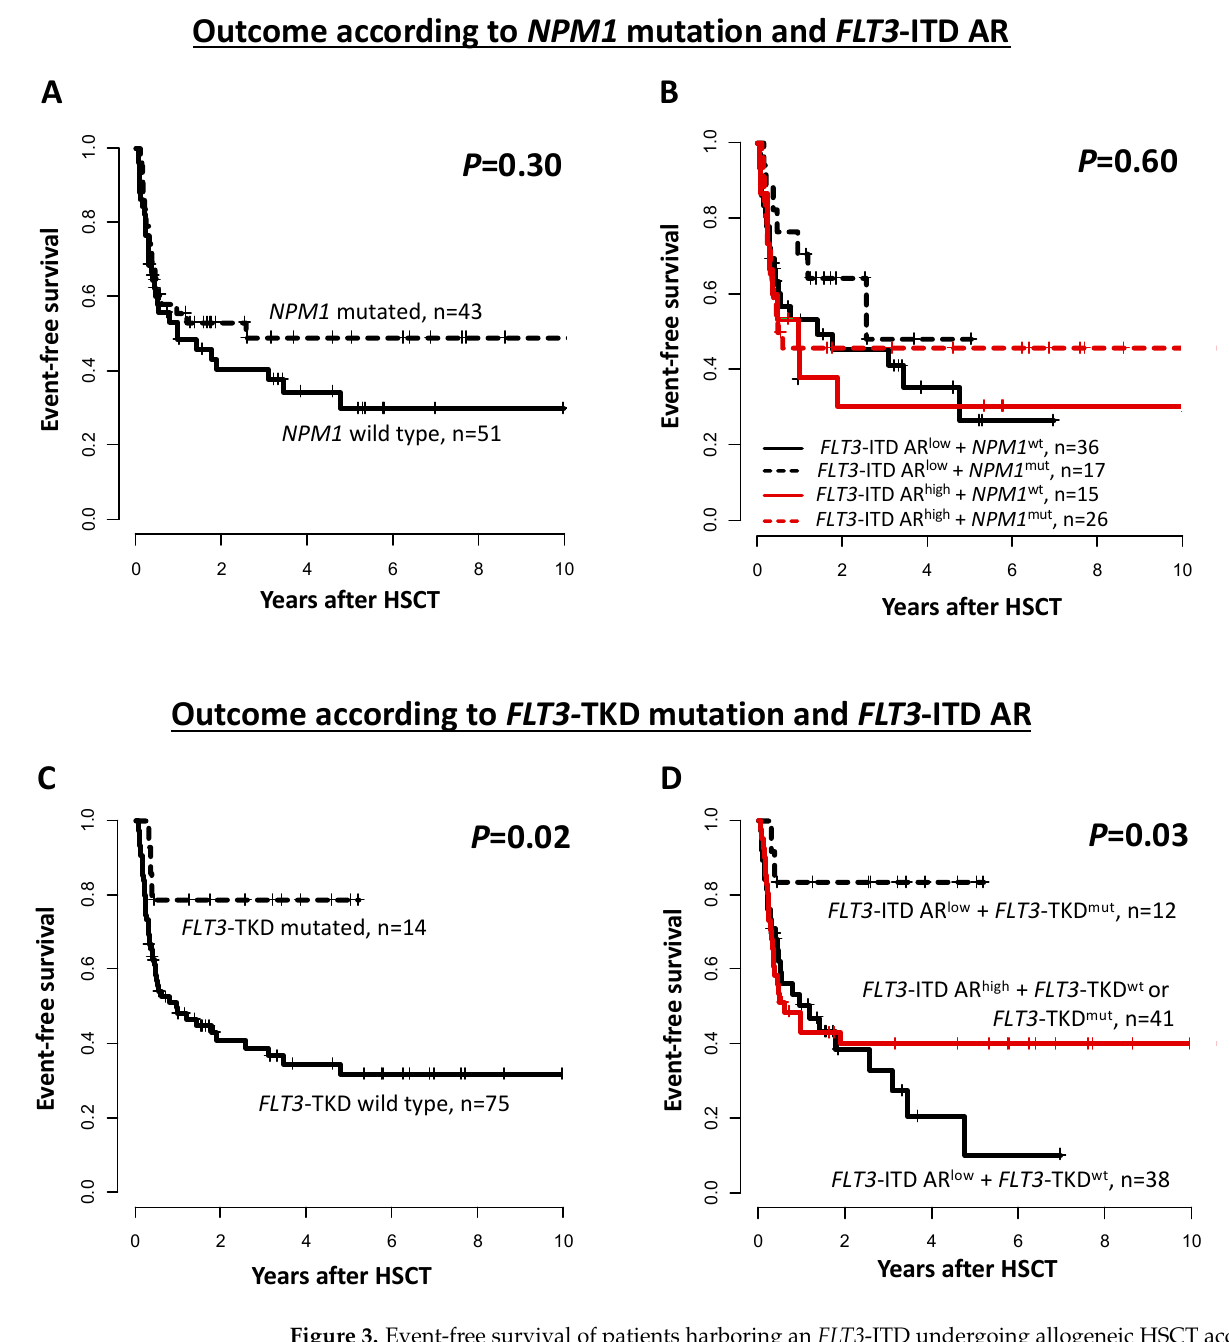
Figure 3. Event-free survival of patients harboring an FLT3 -ITD undergoing allogeneic HSCT according to ( A ) the mutational status of NPM1, and ( B ) according to the mutational status of NPM1 and the FLT3 -ITD allelic ratio (AR, high vs. low, 0.5 cuts, n = 94), ( C ) the mutational status of FLT3 -TKD, and ( D ) according to the mutational status of FLT3 -TKD and the FLT3 -ITD AR (high vs. low, 0.5 cuts, n = 89).